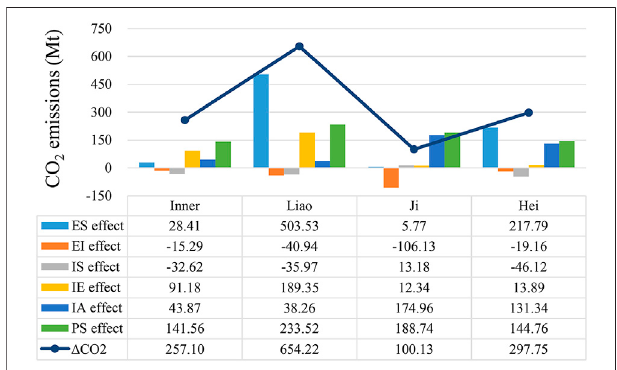
FIGURE 5 | Temporal decomposition of CO 2 emission changes in the four northeastern regions, 2002 –